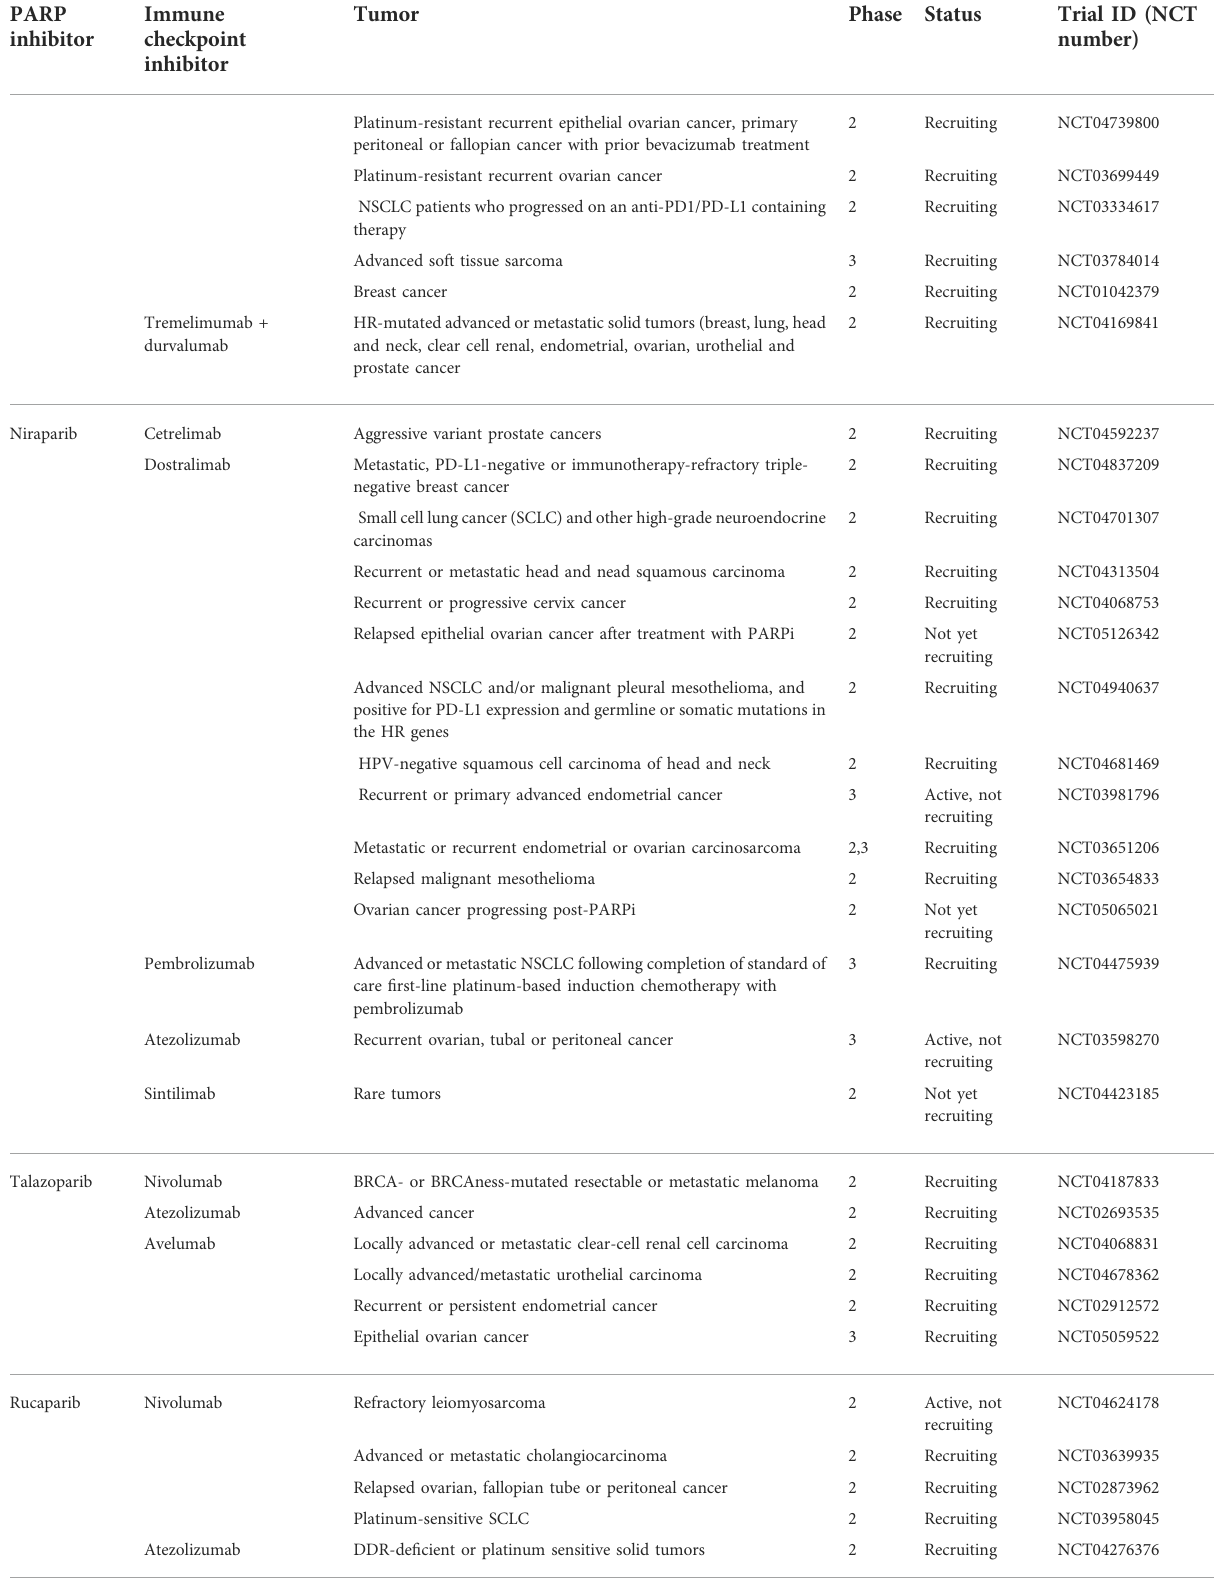
TABLE 3 ( Continued ) List of selected PARP inhibitors and immune checkpoint inhibitors combination therapies. Full access to the research studies description is available on